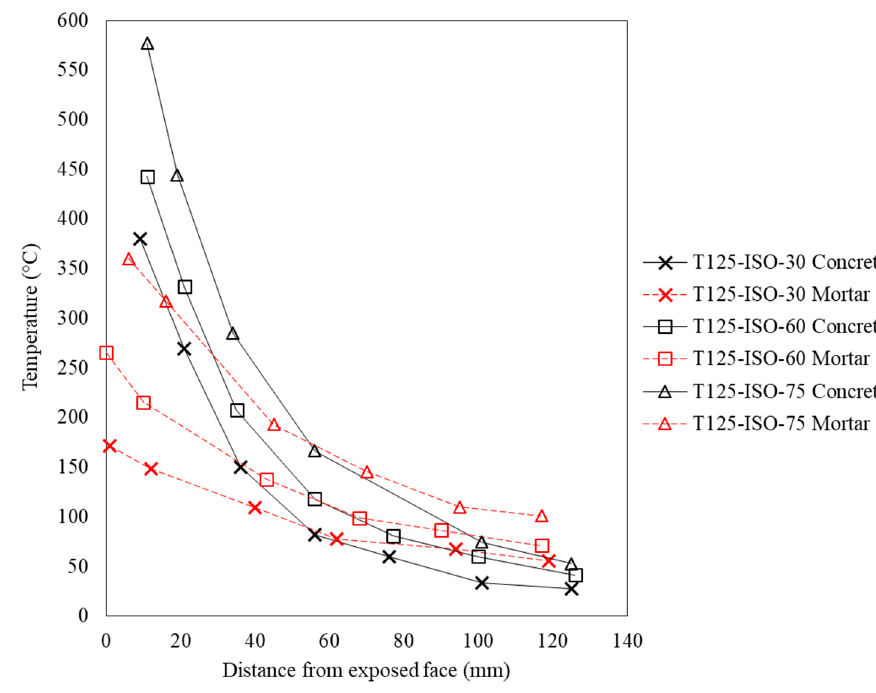
Figure 6. Thermal profiles in concrete and mortar with ISO 834-1 fire conditions.